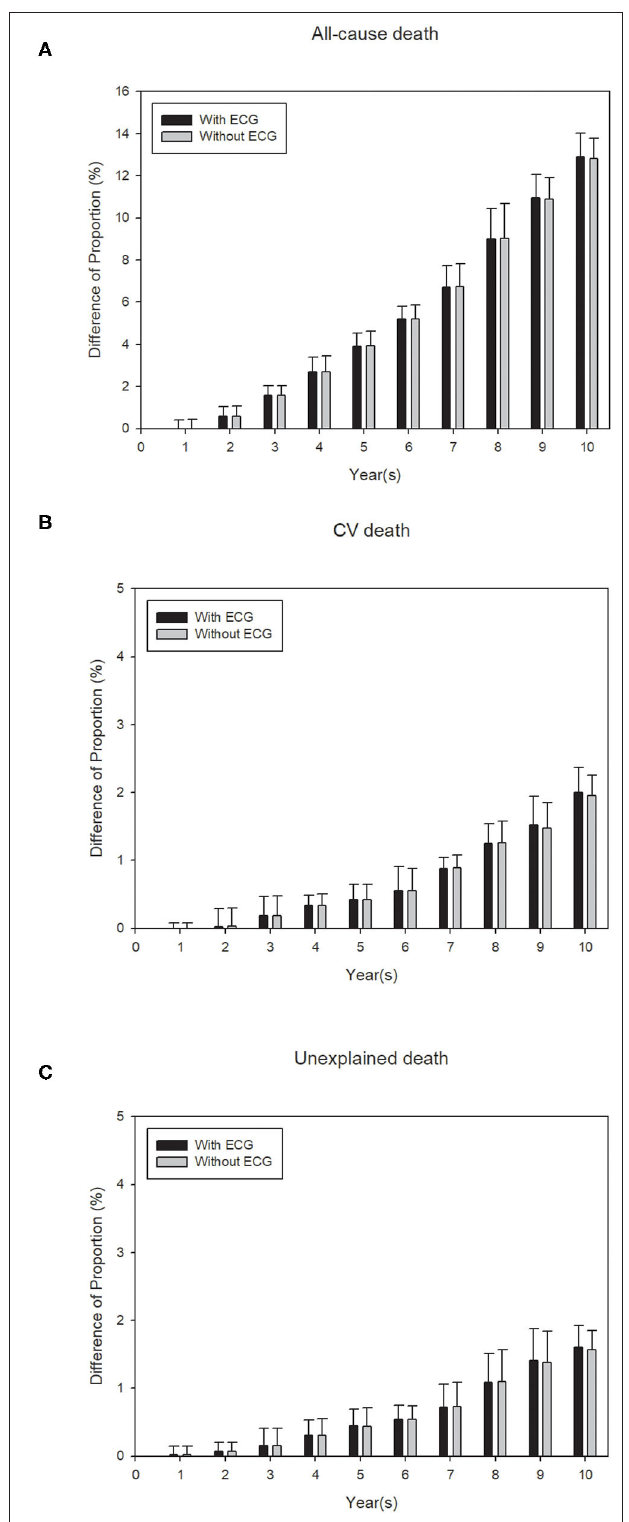
FIGURE 3 | Calibration plots for the events (A) all-cause death, (B) cardiovascular death and, (C) unexplained death, to show the difference